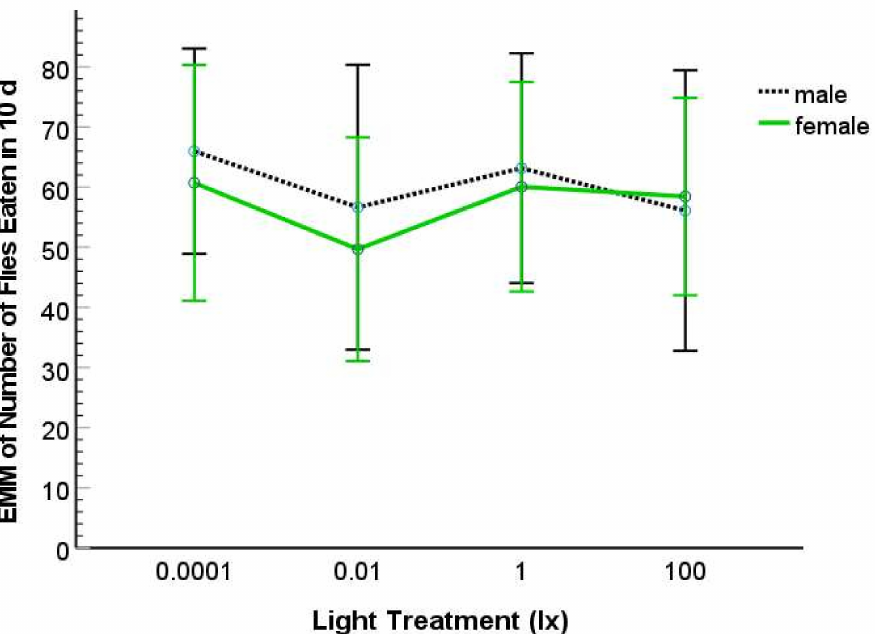
Figure 3. Estimated marginal means (EMM) for number of flies that male and female salamanders consumed in a 10-day-period when exposed to 0.0001, 0.01, 1, or 100 lx ambient nocturnal lighting. The error bars represent 95%